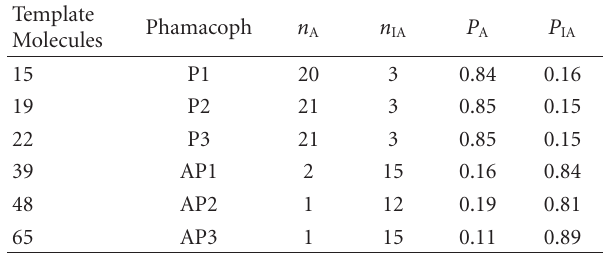
Table 2: Statistical estimates for the pharmacophores.